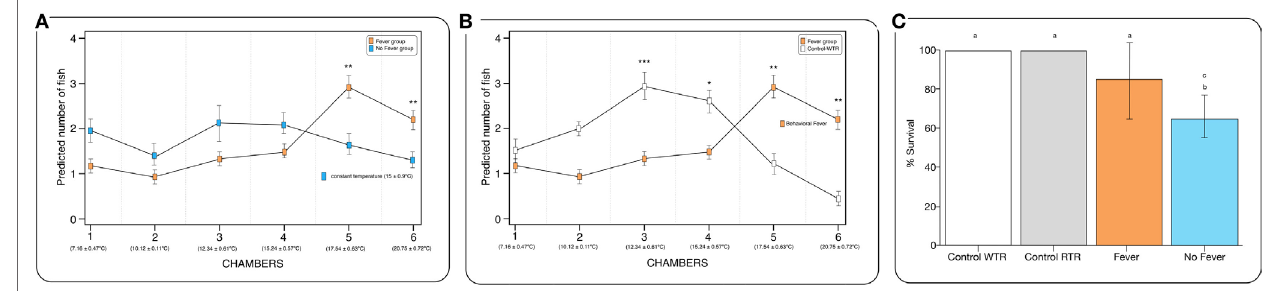
FigUre 2 | Behavioral fever in infectious pancreatic necrosis virus (IPNv)-challenged Salmo salar . (a) Frequency of chamber occupation in individual fish challenged with IPNv (fever vs no fever). The blue box represents fish challenged with IPNv under constant temperature. The orange box represents fish challenged with IPNv under thermal gradient tank ( n = 10 mean ± SD, * p , 0.05; ** p , 0.01; *** p , 0.001). (B) Frequency of chamber occupation in individual fish challenged with IPNv in a thermal gradient tank (orange boxes) and control individuals (no infected group in thermal gradient tank, white boxes control-WTR; n = 10 mean ± SD, * p , 0.05; ** p , 0.01; *** p , 0.001). All individuals used were conditioned at constant temperature under 9-month (15 ± 0.9°C). (c) Survival percentage, the results are presented as the percentage of surviving fish after 10 days post viral challenge (mean ± SD, two-way ANOVA F 2,39 = 14.89; unlike letters denote significantly